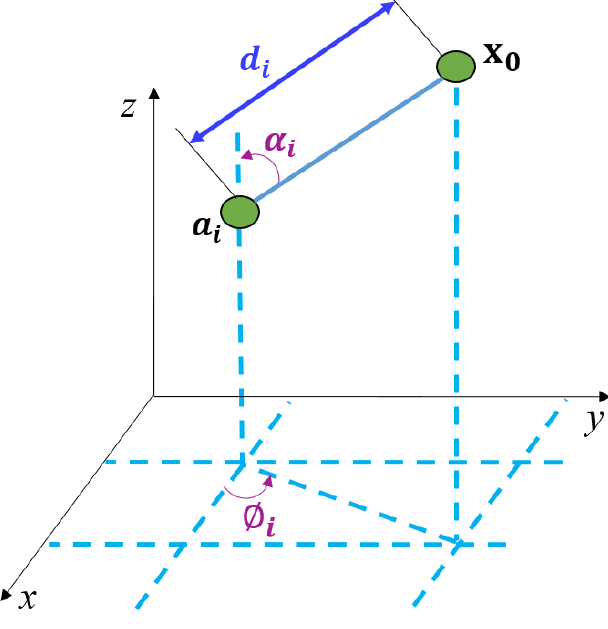
Figure 15. Geometry of the sensor and target location in 3D [89].